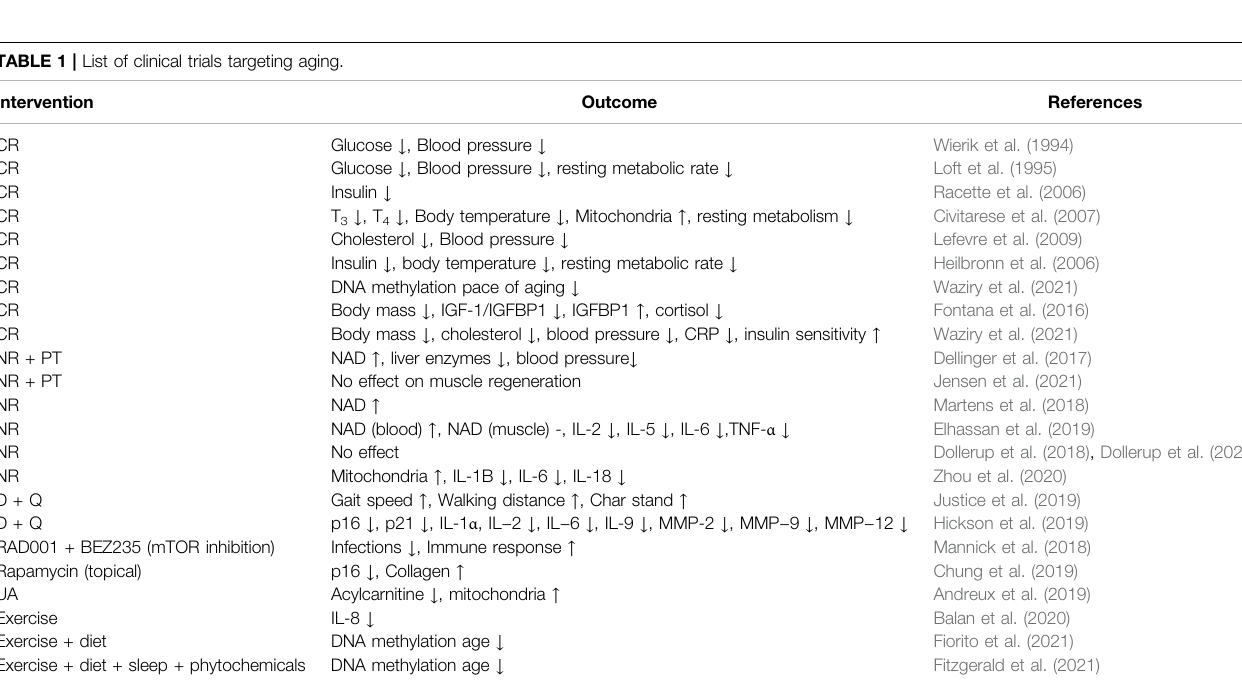
TABLE 1 | List of clinical trials targeting aging.